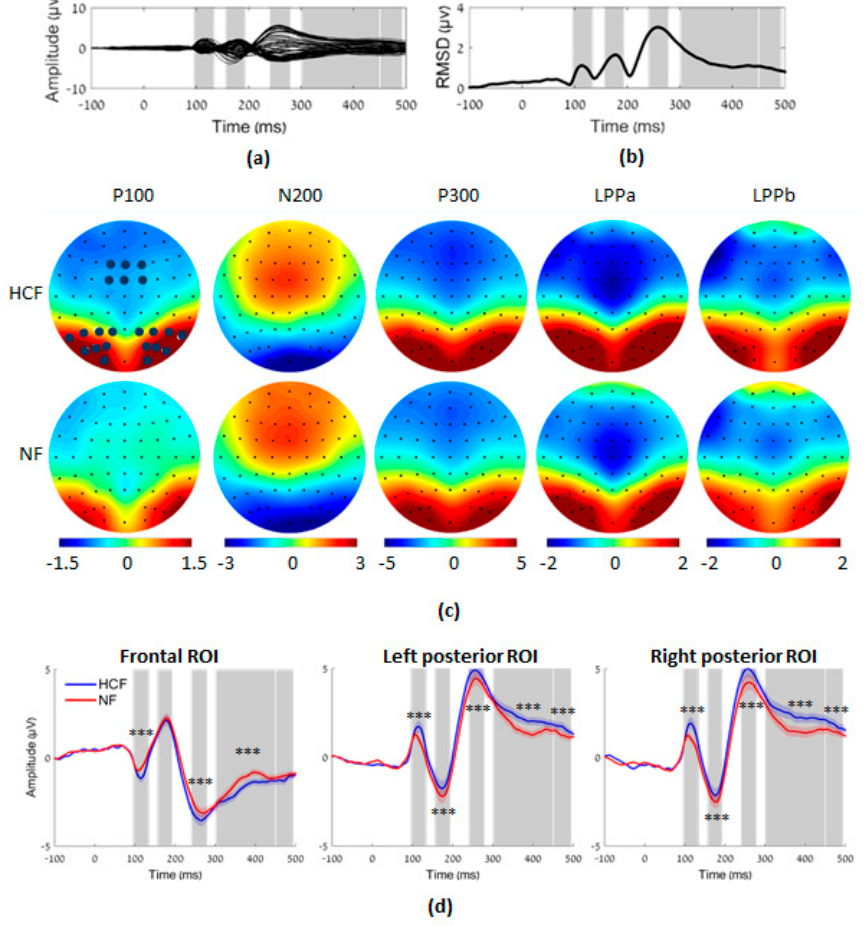
Figure A2. Event-related components in response to food (HCF) and nonfood (NF) images. Data is averaged for all participants together, regardless of group affiliation. ( a ) A butterfly plot of potential curves that include all electrodes. ( b ) Global mean field potential (GMFP) computed sample-wise as the root mean squared deviation (RMSD) from the mean amplitude of all electrodes. The different event-related components and time windows of interest (marked gray) were defined according to the peaks in GMFP and are in line with the literature [65,79]; from left to right: P100 (95–135 ms), N200 (155–195 ms), P300 (240–280 ms), and the Late Positive Potential (LPP) subdivided into LPPa (300–450 ms) and LPPb (450 495). ( c ) Topographic plots of the mean potentials during the different components following HCF and NF images. The frontal, right posterior, and left posterior regions of interest (electrodes marked in dark blue) were defined to capture differences in brain potentials induced by the food images. ( d ) Event-related potential curves in response to HCF and NF images.